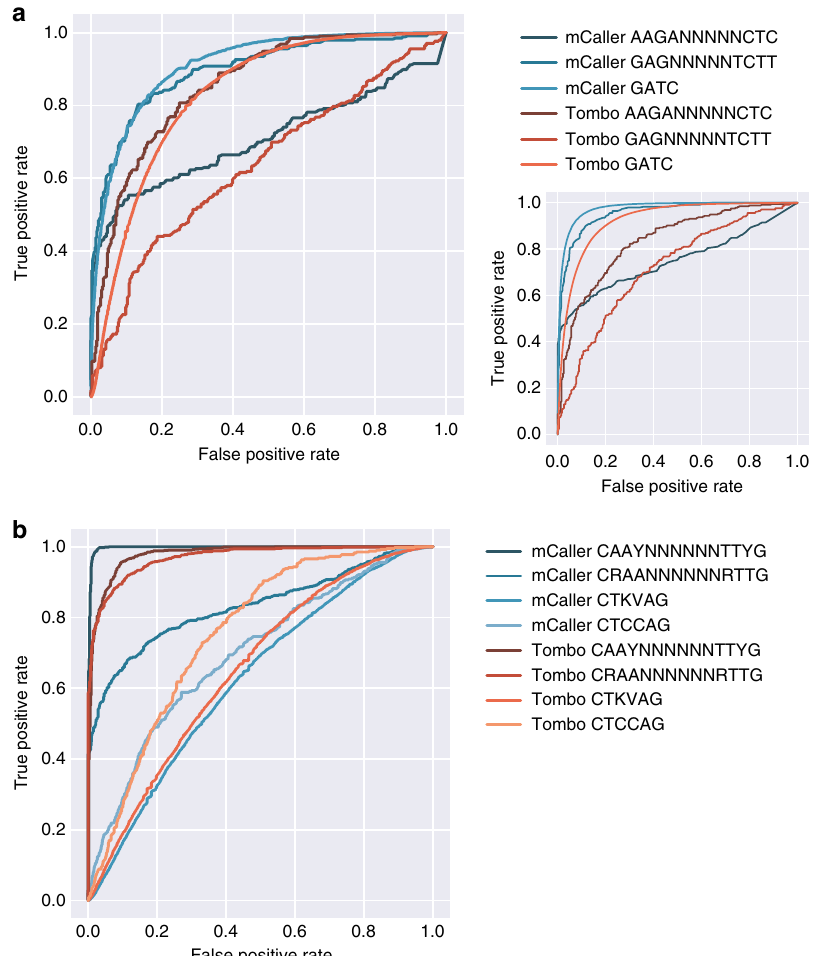
Fig. 4 Comparison to Tombo. a Precision-recall curves for E. coli motifs called by mCaller (per-position calls, for comparison to Tombo) and Tombo for a model trained using E. coli data, with true negatives corresponding to the same motifs within P. aeruginosa . Inset: comparison to true negatives drawn from a random set of true unmethylated motif positions within E. coli suggests GATC motifs are more frequently identi fi ed as methylated by both mCaller and Tombo than random adenines. b Precision-recall curves for untrained motifs in E. faecalis , with true negatives again drawn from P.